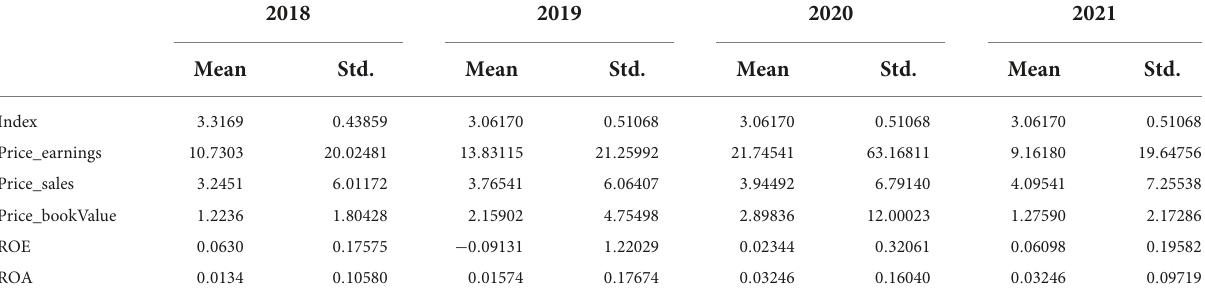
TABLE 5 Summary of indicators (main market).